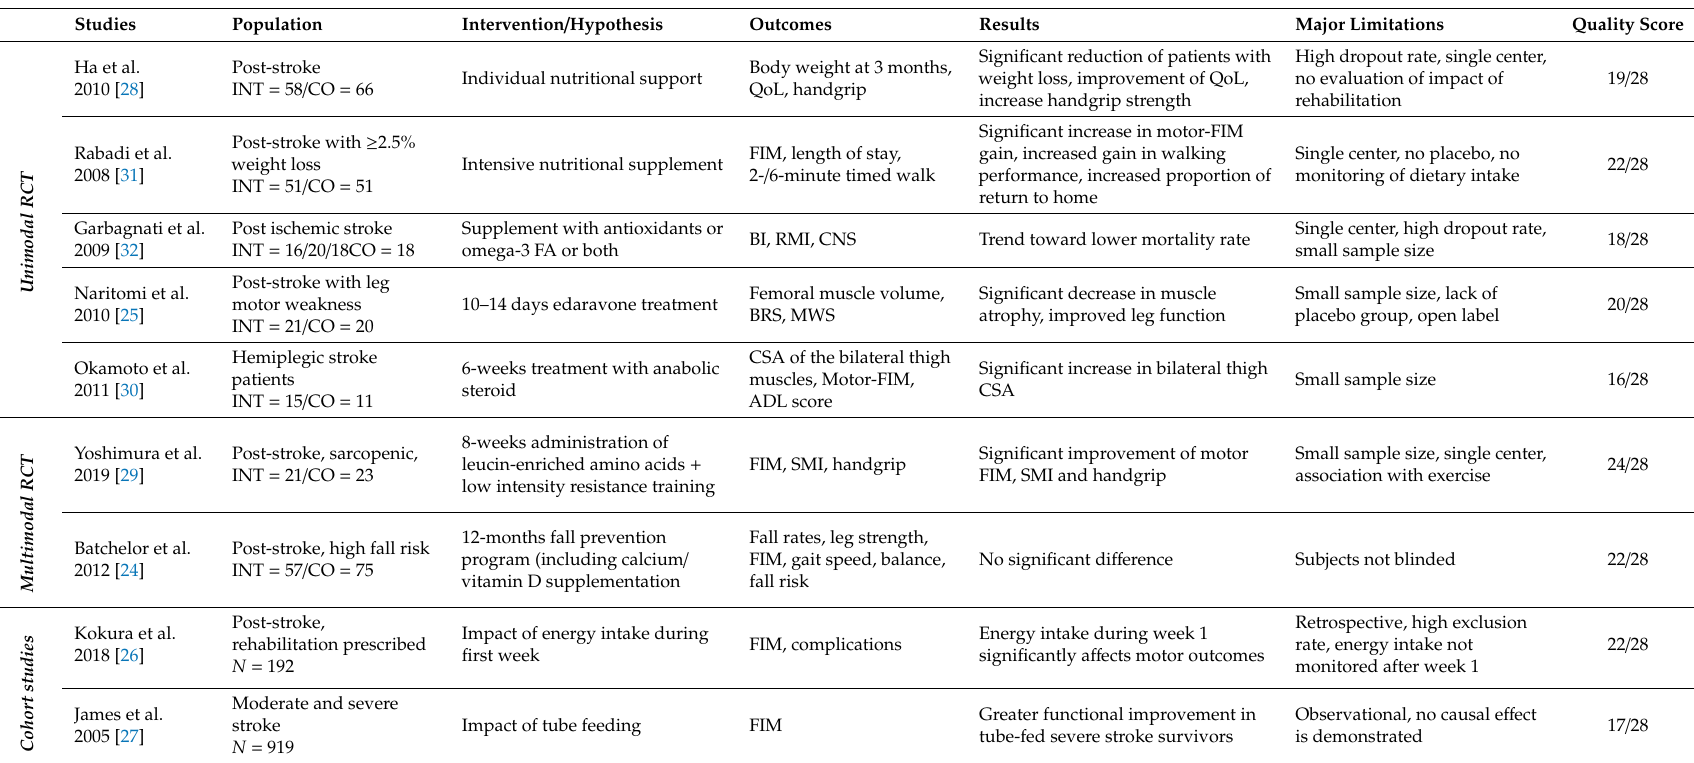
Table 1. Selected